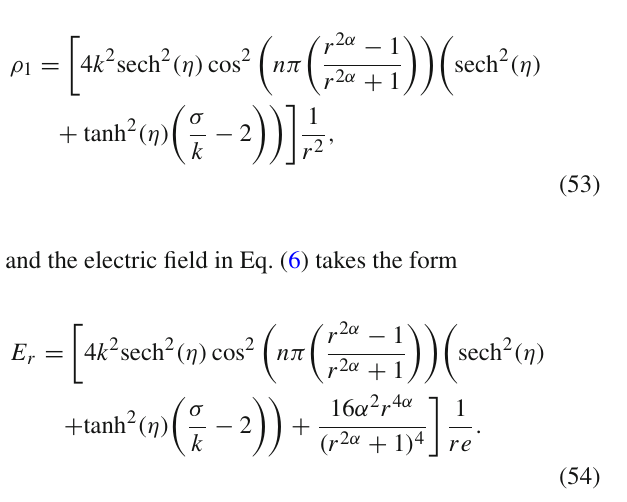
present 2 n inflection points that appear due to the form of the function f